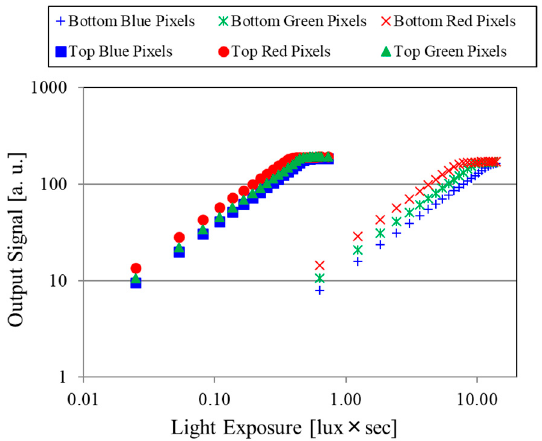
Figure 3. Photoelectric conversion characteristics of PDs in top and bottom substrates. Each PD array on the substrates captures incoming light properly and shows linear photoelectric conversion characteristics.